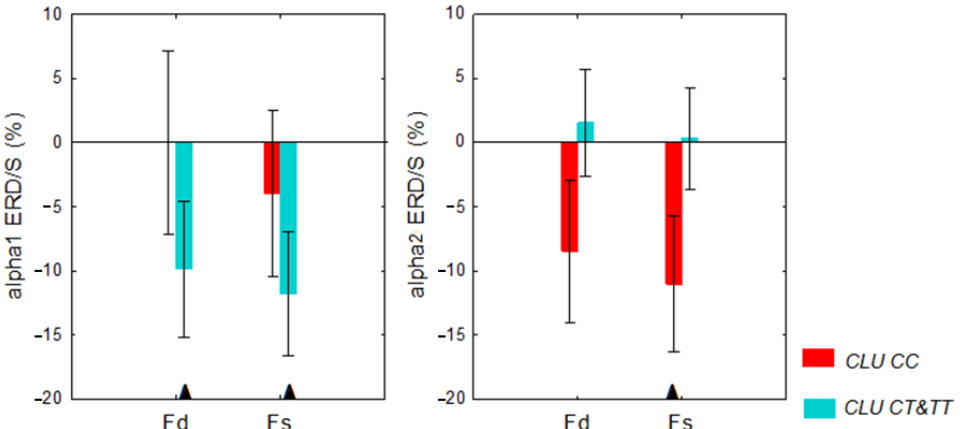
Figure 1. Alpha1 and alpha2 desynchronization/synchronization (ERD/S) in the right (Fd) and left (Fs) frontal regions during the letter fluency test (LFT) in nondemented individuals aged 19 to 80 years with different CLU genotypes. Triangle indicates significant ERD/S. The e ff ect of CLU genotype on alpha band desynchronization during LFT was signif- icant beginning at 30 years of age. The demographic characteristics of participants aged 30 to 80 years are presented in Table 2. There were no signi fi cant di ff erences in age, sex, APOE genotype, or LFT performance between the CLU CC and CLU CT&TT carriers ( p > 0.05). Table 2. Demographic information, APOE genotype, and LFT performance of nondemented indi- viduals aged 30 to 80 years with di ff erent CLU genotypes. N